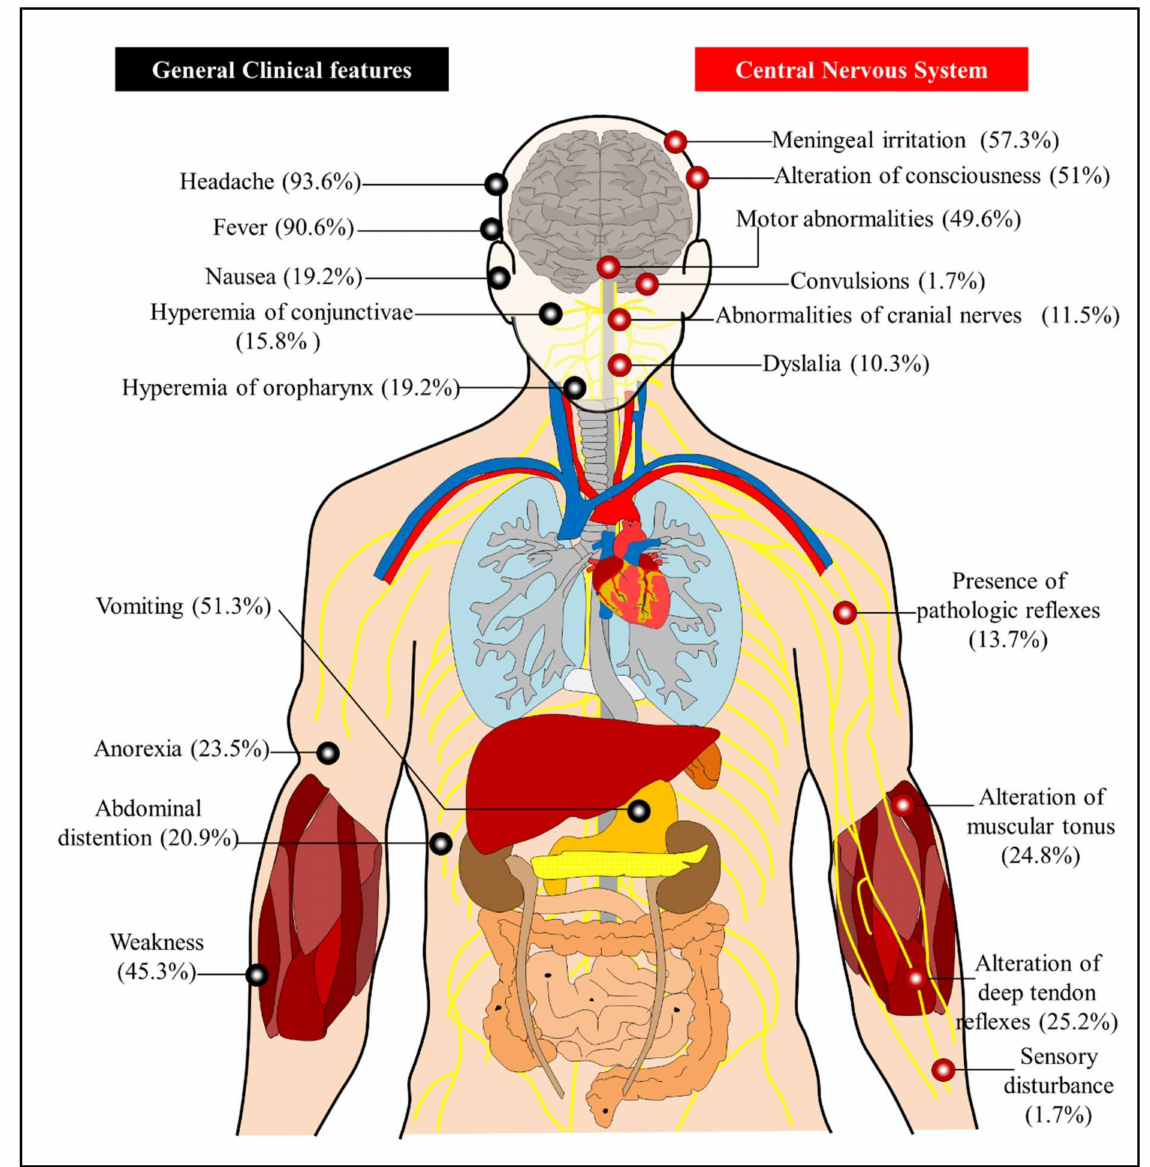
Figure 4. Clinical features of patients following ROCV